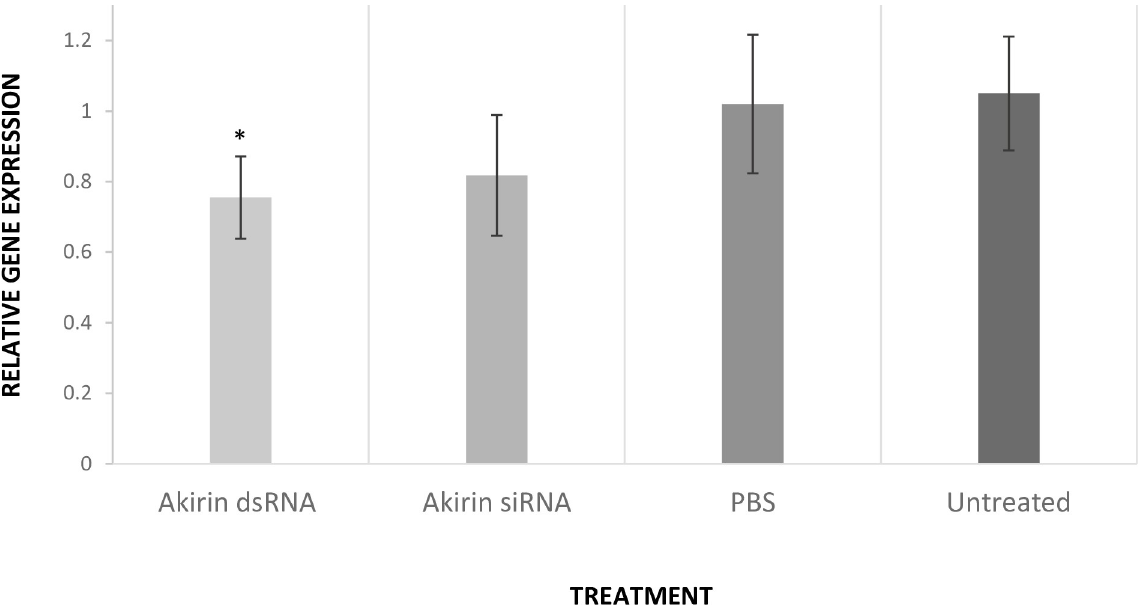
Fig 1. The change in Akirin relative expression assessed 3-days post-RNAi treatment. The relative expression of Akirin was significantly downregulated by a mean factor of 0.76 ( p = 0.02), when comparing the expression ratios between the Akirin dsRNA treated samples and the negative control samples. The relative expression of Akirin remained unchanged when comparing the expression ratios of the negative control samples (Mouse-ß2m siRNA) to the PBS treated samples ( p = 0.78) and untreated samples ( p = 0.83).